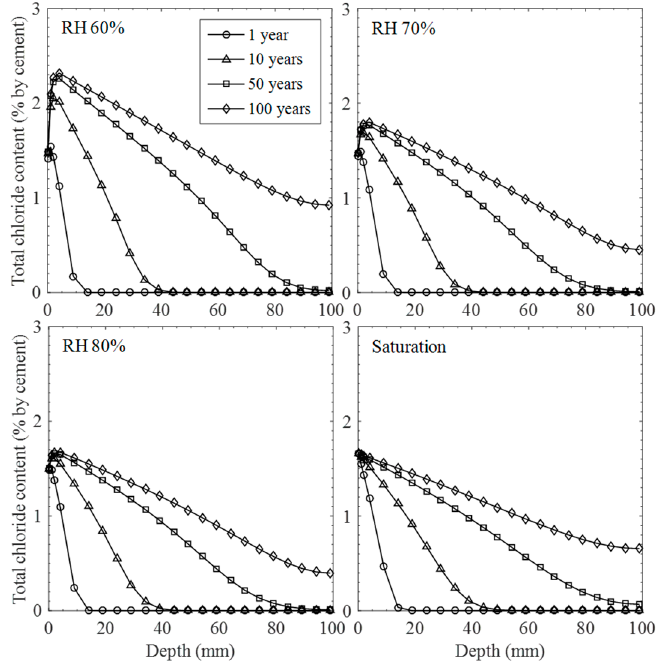
Figure 4. Time dependent concentration profiles for cyclic chloride exposure with different ambient humidity levels.